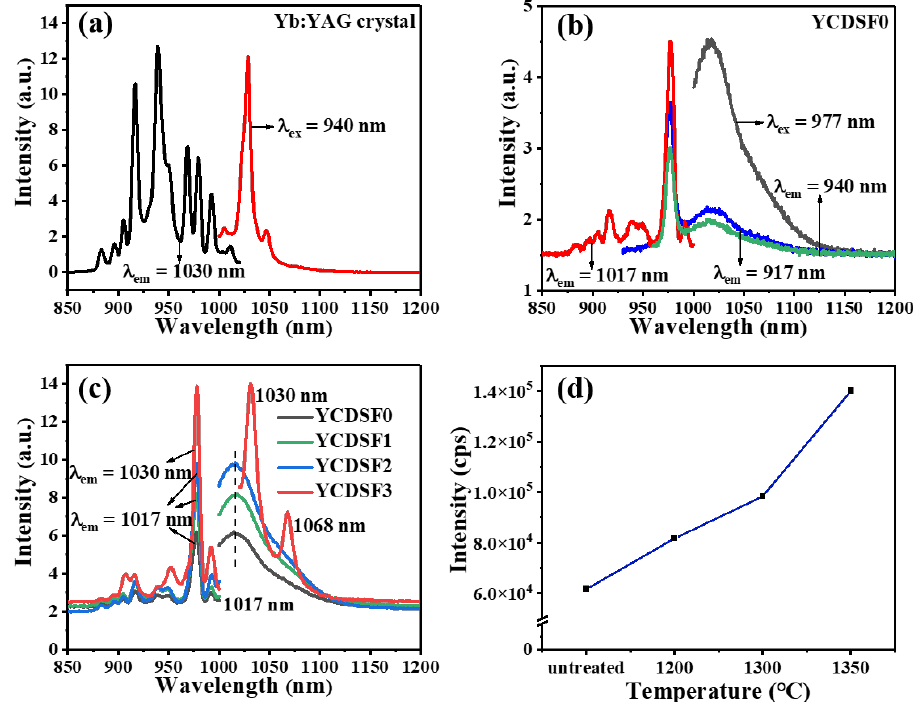
Figure 4. Excitation and emission spectra of the ( a ) Yb: YAG crystal, ( b ) YCDSF0, and ( c ) YCDSF heat treated at different temperatures. ( d ) Emission intensity at different heat-treated tempera- tures.